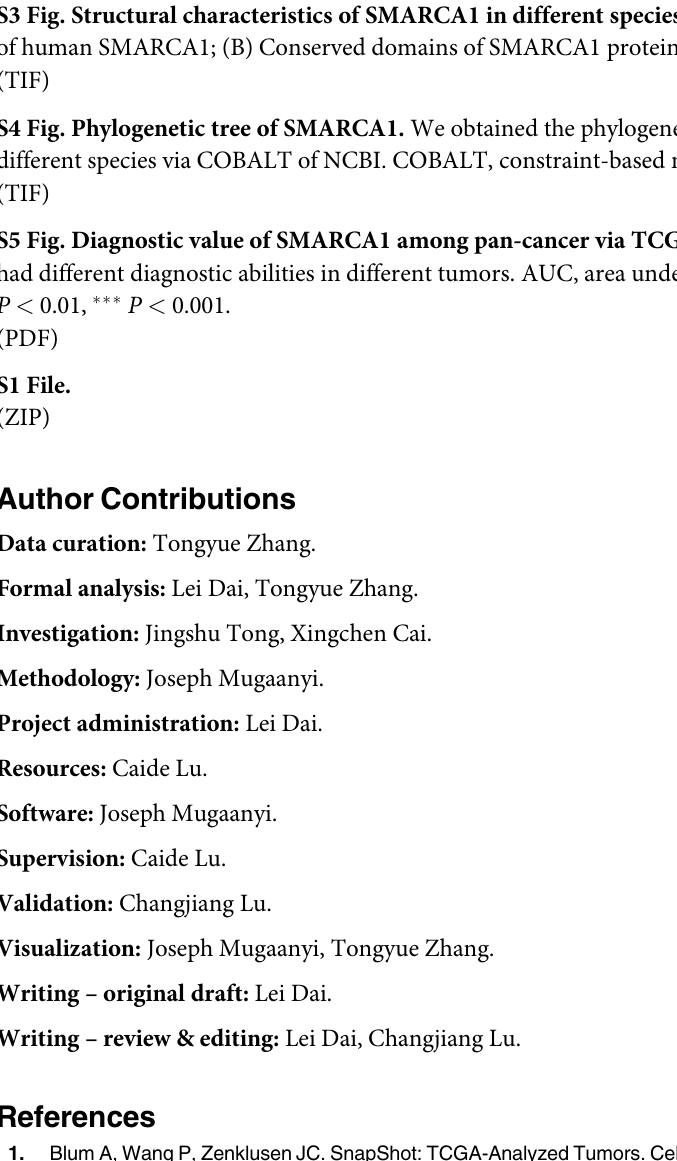
(TIF) S2 Fig. A flowchart for methods and materials. (PDF) S3 Fig. Structural characteristics of SMARCA1 in different species. (A) Genomic location of human SMARCA1; (B) Conserved domains of SMARCA1 protein among diverse species. (TIF) S4 Fig. Phylogenetic tree of SMARCA1. We obtained the phylogenetic tree of SMARCA1 in different species via COBALT of NCBI. COBALT, constraint-based multiple alignment tool. (TIF) S5 Fig. Diagnostic value of SMARCA1 among pan-cancer via TCGA + GTEx. SMARCA1 had different diagnostic abilities in different tumors. AUC, area under curve. � P < 0.05, �� P < 0.01, ��� P <